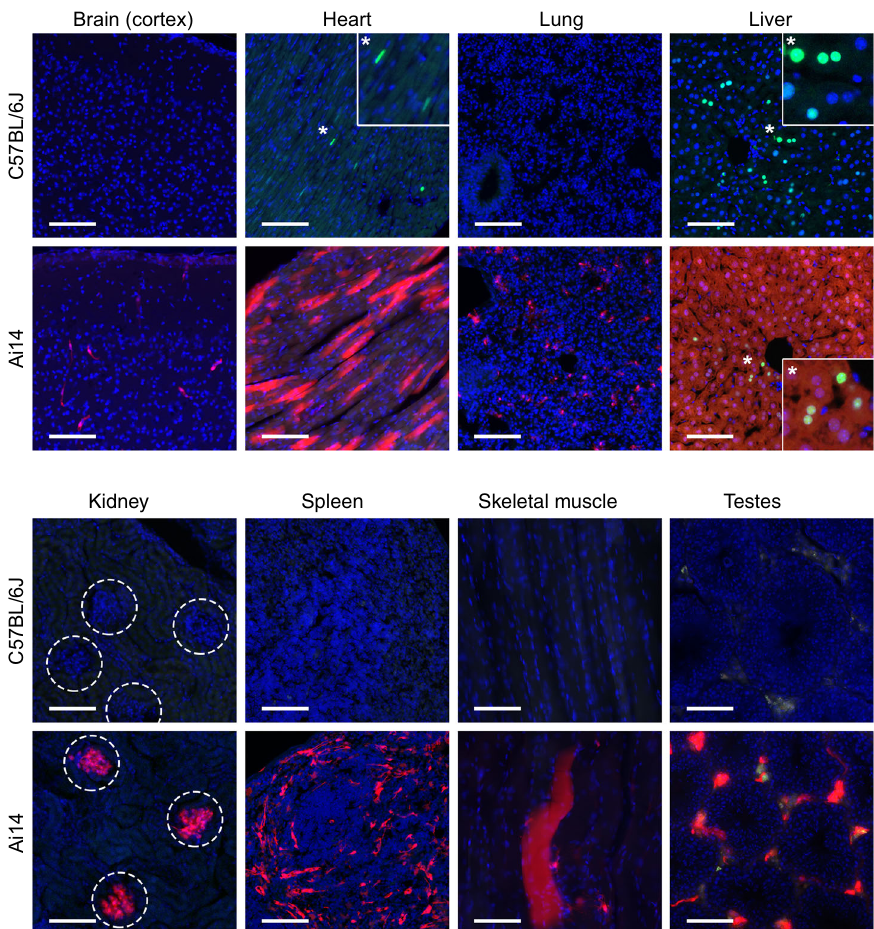
Fig. 5 Ai14 mice capture AAV8 transgene expression across tissues. Representative photomicrographs of tissue from C57BL/6J or Ai14 mice at 2 weeks post IV delivery of 3.16e11 vg AAV8-Cre-eGFP per mouse. eGFP (green), tdTomato expression (red), and nuclei (blue) are shown. n = 3 for C57BL/6J and Ai14 mice. Insets in heart and liver highlight nuclear eGFP expression. Dashed circles highlight glomeruli. Auto fl uorescent material is present in testes. Scale bars = 100 µ